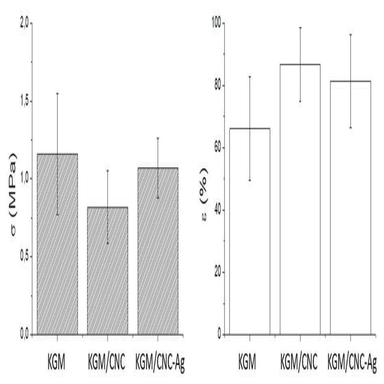
Tensile strength, σ (MPa), and elongation module, ԑ (%), of KGM, KGM/CNC and KGM/CNC-Ag asymmetric membranes.